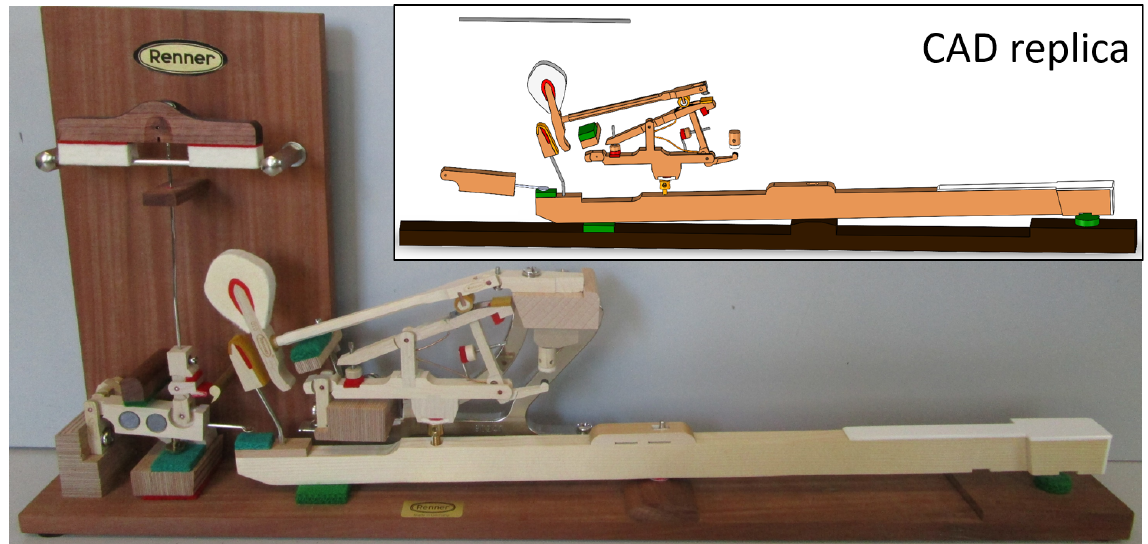
Figure 1. Grand piano action and its Computer Aided Design (CAD)